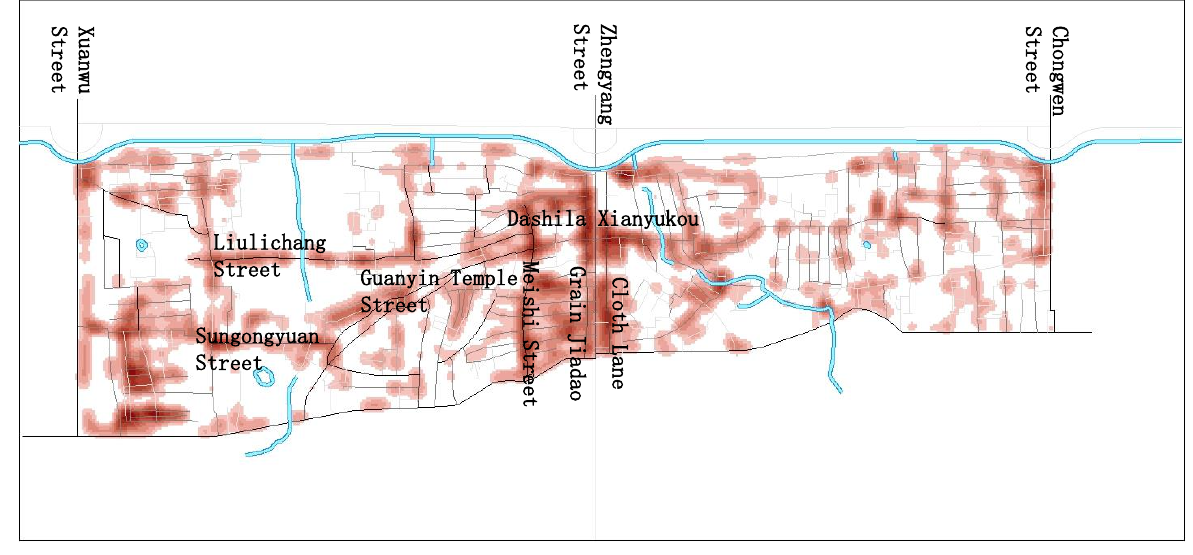
Figure 9. Distribution characteristics of continuous building